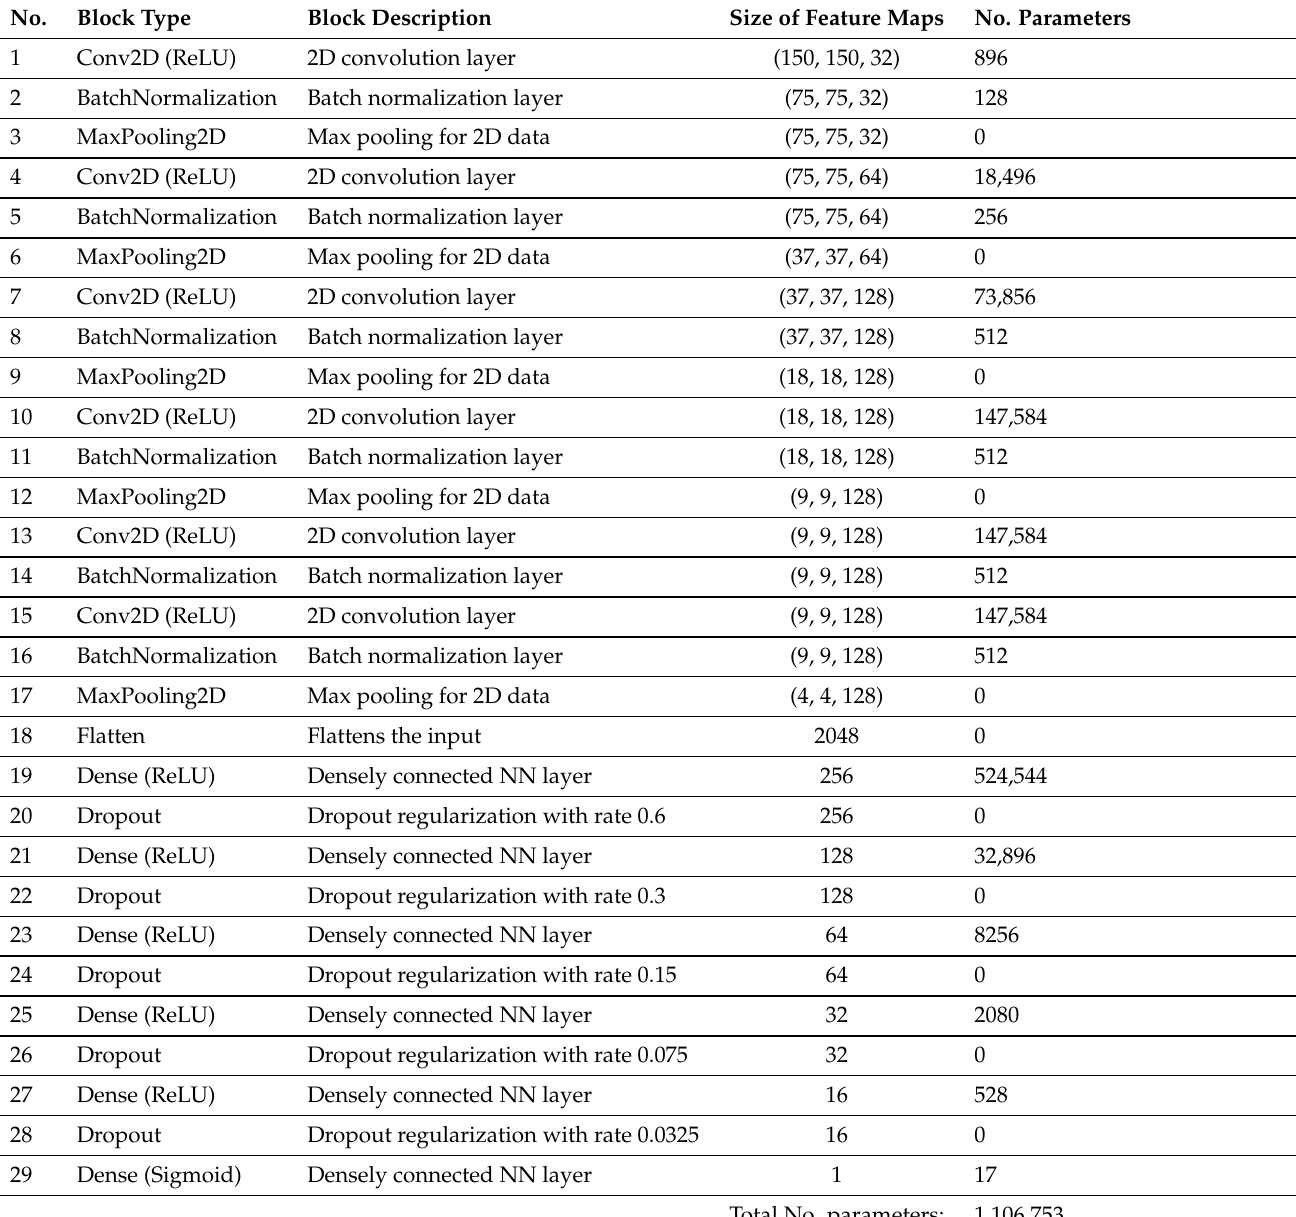
Table 2. Summary of the LW-FIRE150 deep convolutional neural network